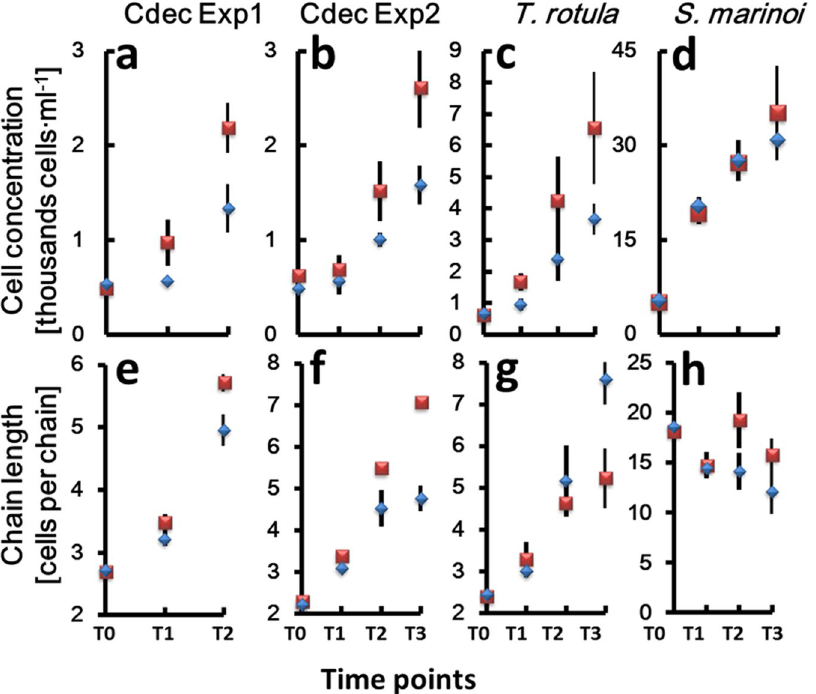
Figure 2. Growth curves expressed as cells · ml − 1 (y-axis) ( a–d ) and mean chain length expressed as number of cells per chain (y-axis) ( e – h ) over the time points (x-axis). ( a , e ) Chaetoceros decipiens experiment 1; ( b , f ) Chaetoceros decipiens experiment 2; ( c , g ) Thalassiosira rotula ; ( d , h ) Skeletonema marinoi . Blue diamonds = turbulence exposed cells. Red squares = still condition. Vertical lines indicate standard deviation. Values have been averaged over the three replicates.